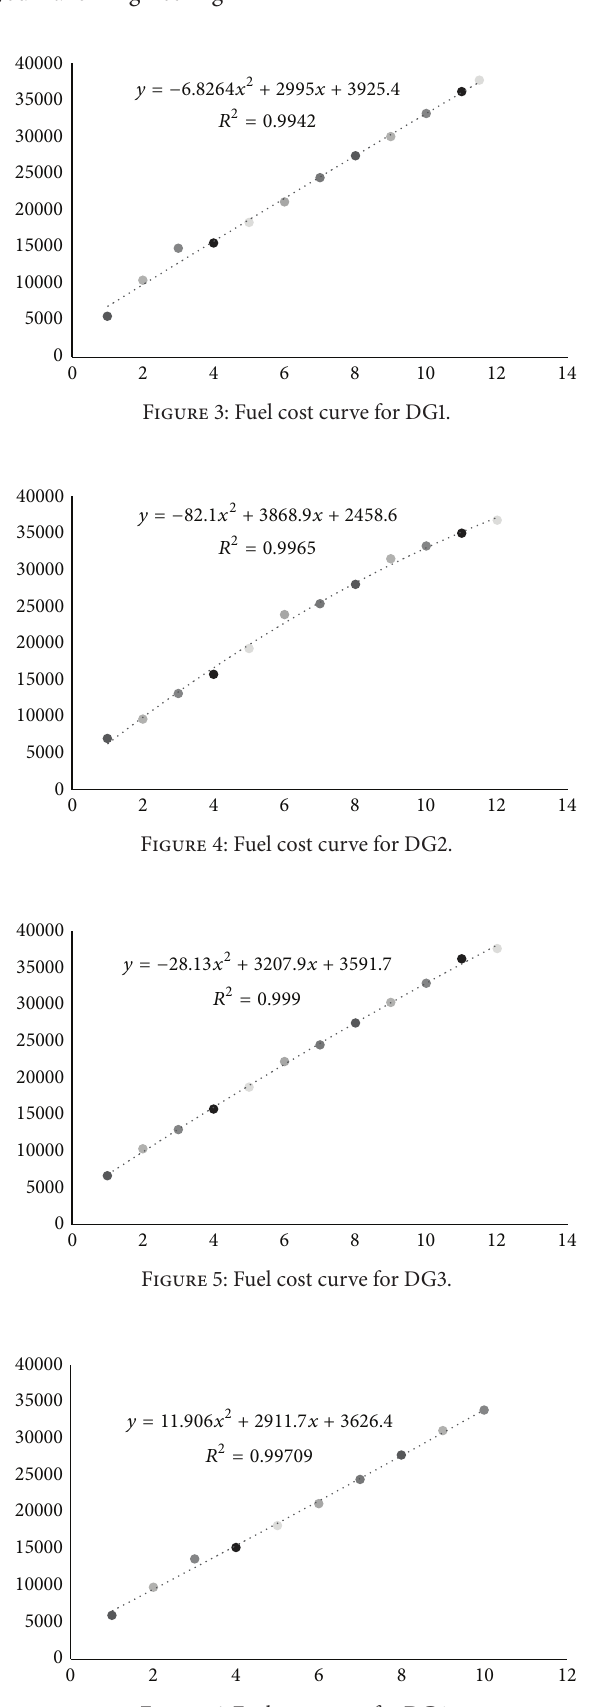
Figure 6: Fuel cost curve for